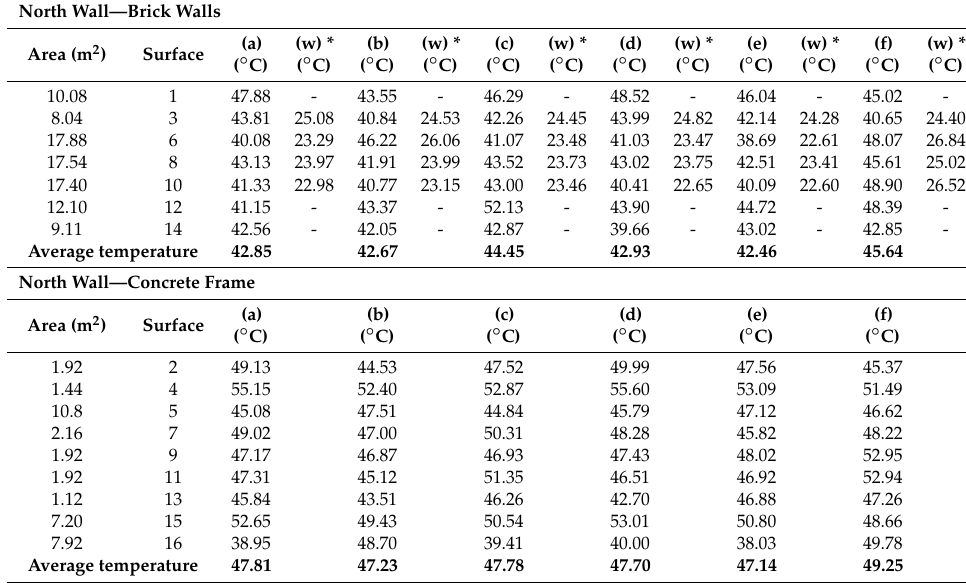
Table 2. Simulated temperatures of the north wall for the initial configuration (a) and for the five case studies where positions/orientations of the fan heaters were changed (b–f).